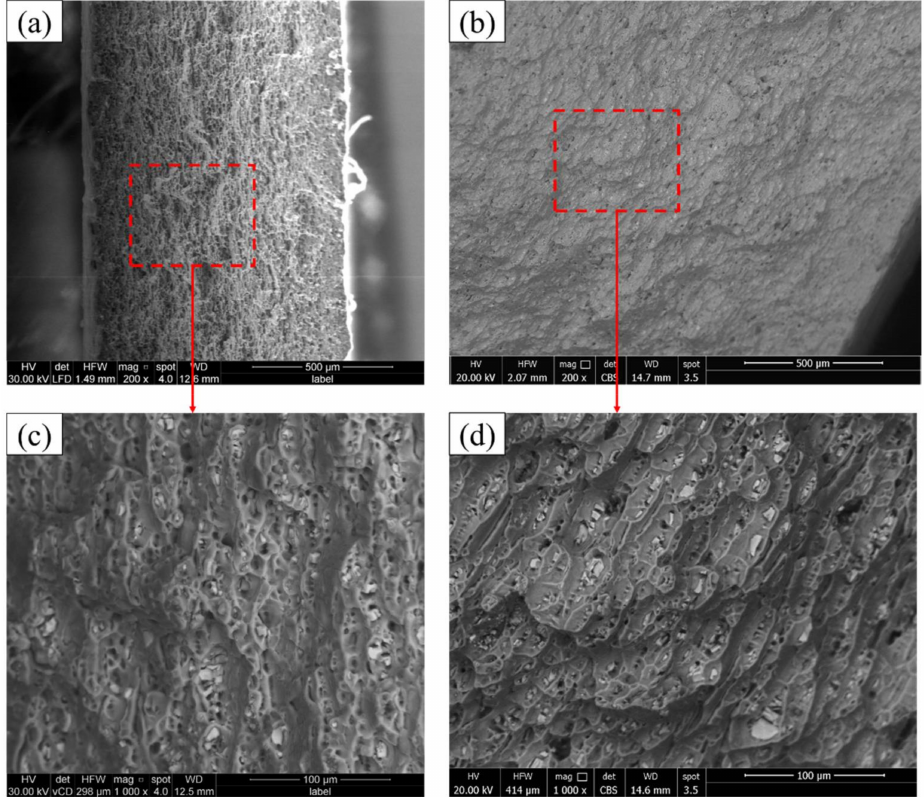
Figure 20. SEM images showing the fracture surface of AA6082-T6 BMs; ( a , c ) 1 mm and ( b , d ) 2 mm at different